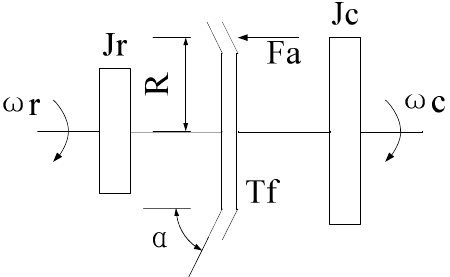
Figure 4. Structural schematic diagram of a single friction cone.